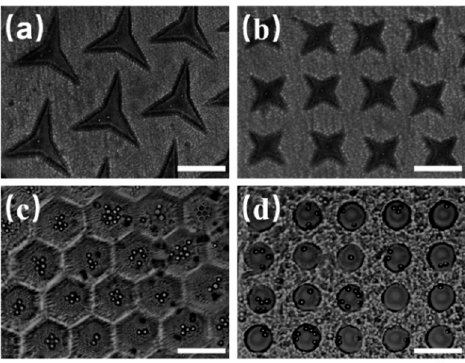
Figure 3. Polystyrene microspheres captured in microwell arrays with different shapes. The patterns are: ( a ) triangular, ( b ) quadrangular, ( c ) honeycomb, and ( d ) circular. Scale bar: 100 μ m.